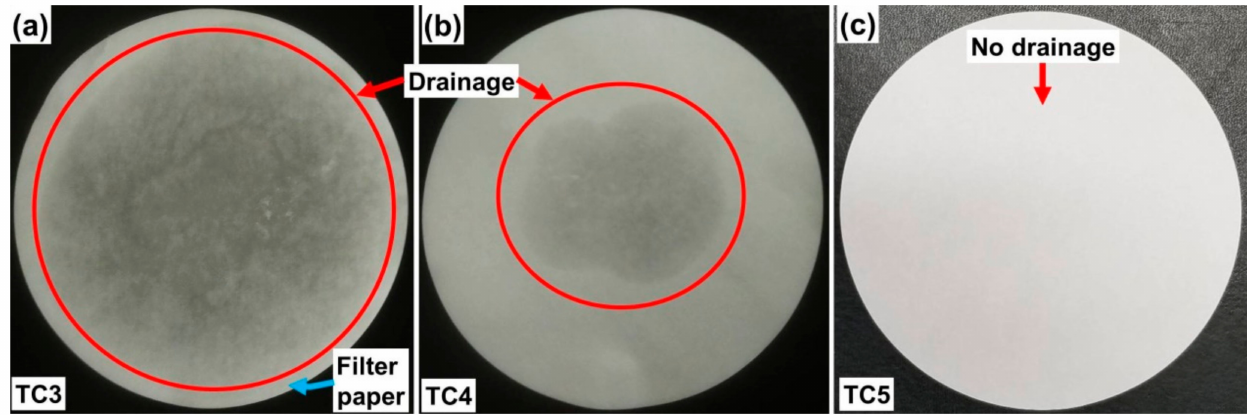
Figure 2. Filter-based OD drainage test of ( a ) TC3, ( b ) TC4 and ( c ) TC5. The red-encircled area depicts the